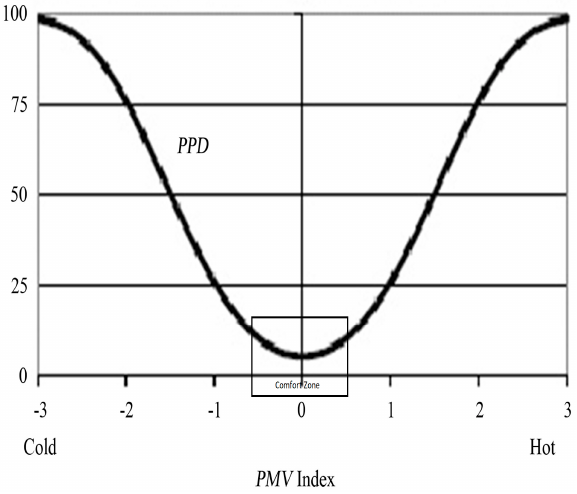
Figure 3. Predicted percentage dissatisfaction (PPD) as a function of predicted mean vote (PMV).